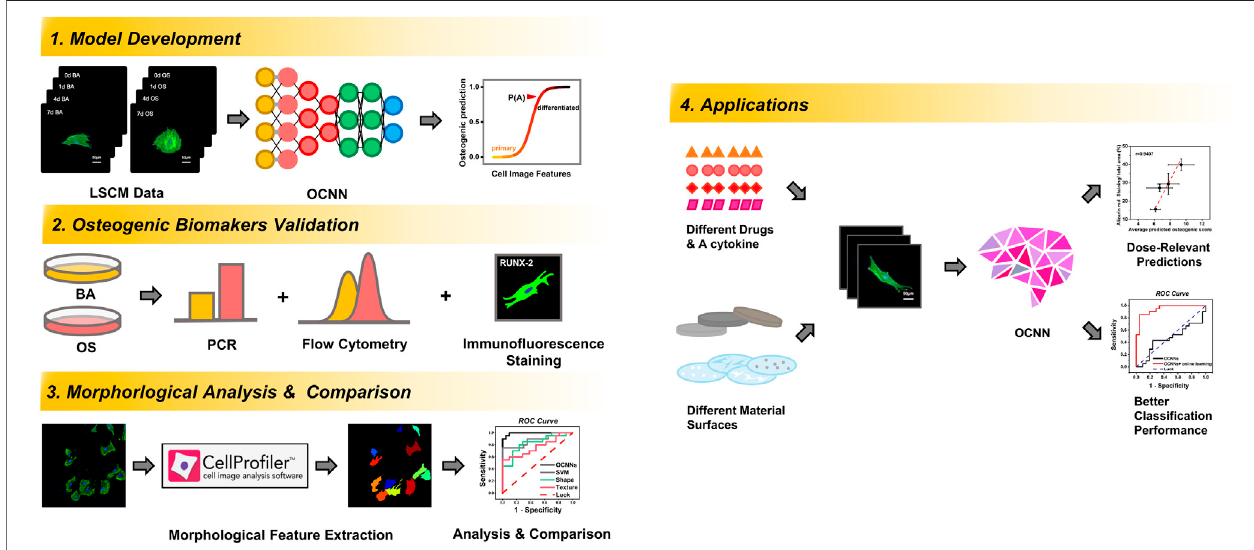
FIGURE 1 | Schematic fl ow chart of the training, validation, comparison, and application procedures and outcomes of OCNN in this study.